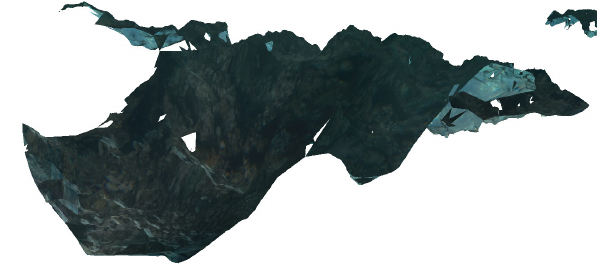
Figure 7. Amazon Web Service: image recognition of a ray In order to train neural networks to recognize specific objects, it is required to annotate some images which contains these objects.